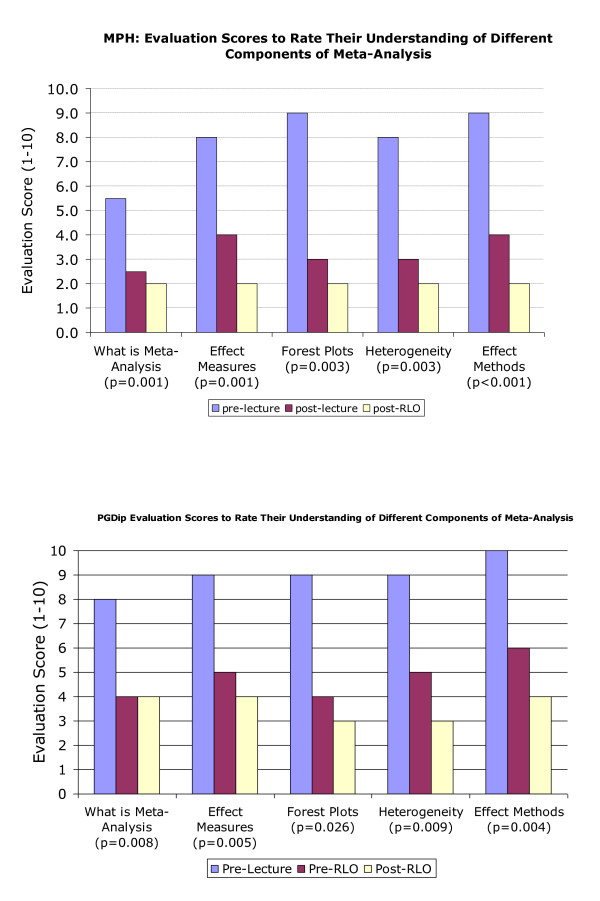
Masters in Public Health (MPH) and Post graduate diploma (PGD) students self reported rating of their understanding of different aspects of Meta-analysis. Masters in Public Health (MPH) and Post graduate diploma (PGD) students self reported rating of their understanding of different aspects of Meta-analysis rated on an ordinal scale of 1 to 10 where 1 is 'Very Well' and 10 is 'Very Badly'. The p values are for the difference in perceived understanding following RLO use (post RLO - cream bars) compared to the rating before the RLO and after the lecture (pre-RLO purple bars).